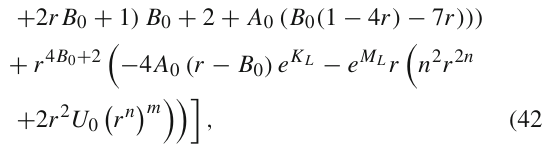
Fig. 25 This panel shows the graphical behavior of energy density (MeV/fm 3 ) , P r (MeV/fm 3 ) , P φ (MeV/fm 3 ) and P z (MeV/fm 3 ) w.r.t radial coordinate. CASE